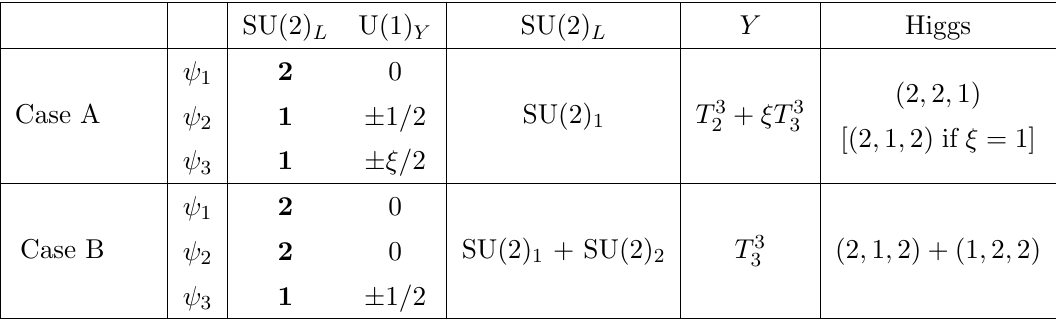
are the diagonal i